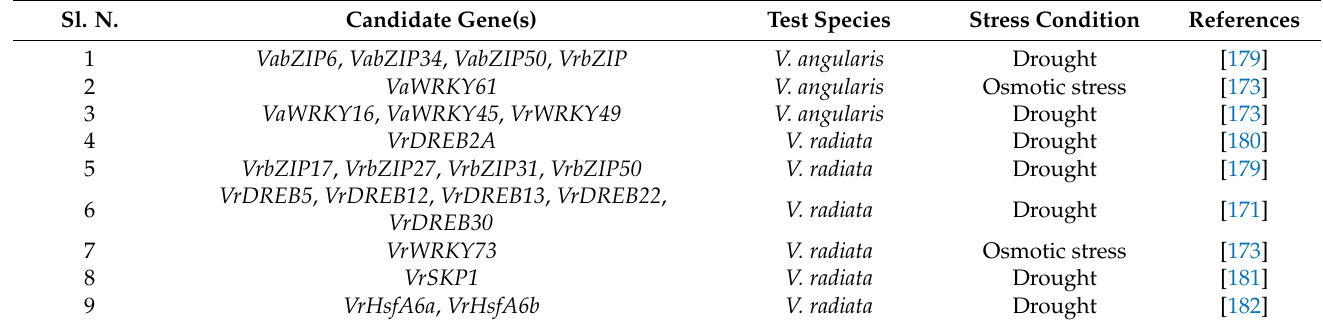
Table 4. Potential candidate genes and transcriptional factors conferring drought tolerance in Vigna spp. Sl. N. Candidate Gene(s) Test Species Stress